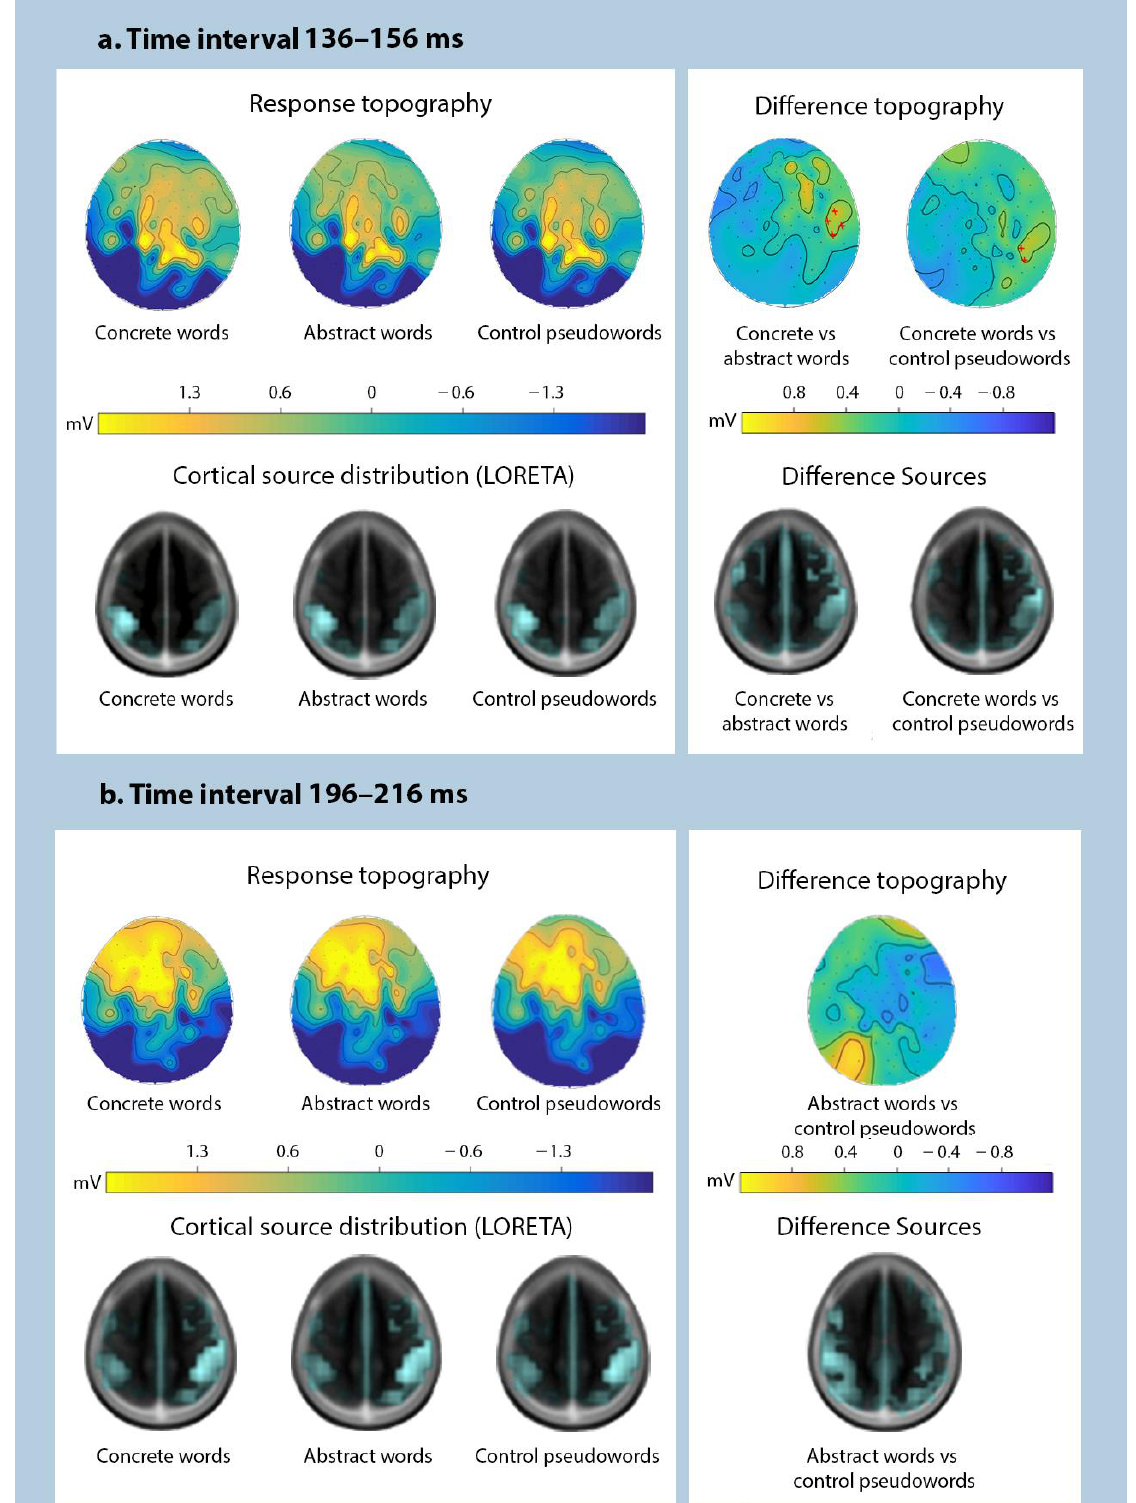
Figure 4. Brain activation in response to novel concrete and novel abstract words and control pseudowords over the main peaks at 136–156 and 196–216 ms for statistically significant contrast indicated by ANOVA. ( Left ): Response topographies and LORETA source distributions (z = 50) of newly learnt and control items. ( Right ): difference topographies and source of ERP differences for significant contrasts between stimulus types. Note: red crosses represent electrodes with significant amplitude differences, surviving corrections in cluster-based permutation tests.